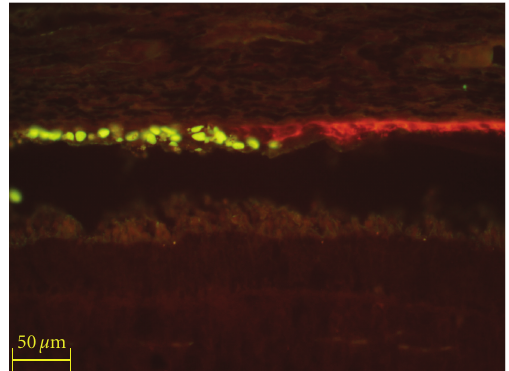
Figure 2: Xenografted human NPCs express GFAP in the porcine subretinal space. Donor cell identified with anti-human nuclear antibody exhibits cytoplasmic labeling for the astroglial marker glial fibrillary acidic protein (GFAP, red), which is also expressed by activated glial cells in the underlying host neural retina. Survival = 10 days.